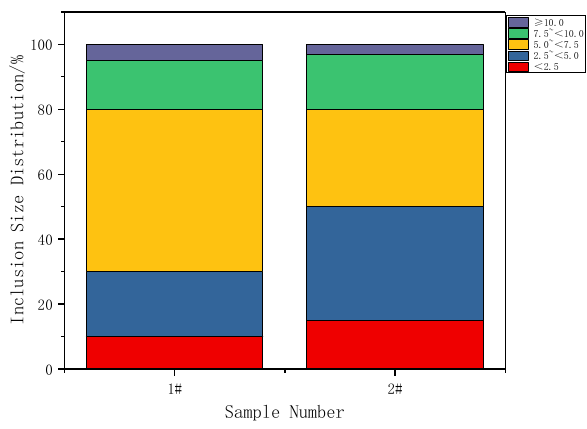
Figure 7. The inclusion size distribution.